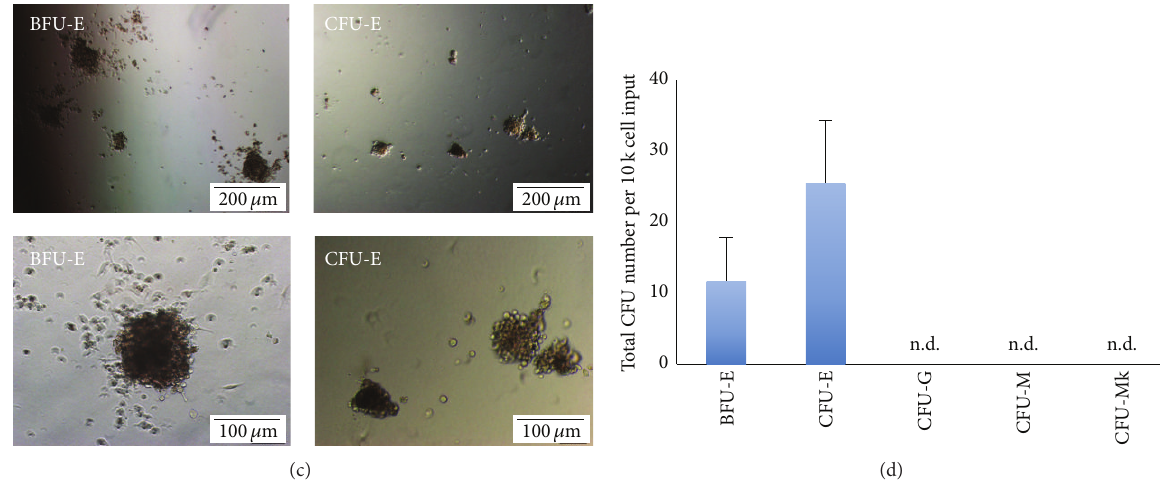
Figure 7: Transdifferentiation of hHFMSCs into erythrocytes without passing by stage of HSC. (a) Cell stained with monoclonal antibody against HSC marker CD34, myeloid progenitor marker CD45, monocyte-macrophage marker CD14, and granulocytic marker CD15. (b) Expression of hematopoietic progenitor markers CD34 and CD45 was detected after hematopoietic stimulation by flow cytometric analysis. On days 3 and 5 after hHFMSC OCT 4 cells were induced by hematopoietic medium, cells were analyzed by staining with fluorochrome- conjugated monoclonal antibodies PE-anti-CD45 and PE-Cy5-anti-CD34. (c) CFU assay images and (d) quantitative analysis of CFU formation ( 𝑛 = 3 ). Erythroid blast forming units, BFU-E; erythroid CFU, CFU-E; monocytic CFU, CFU-M; granulocytic CFU, CFU-G; megakaryocytic CFU, CFU-Mk. n.d.,